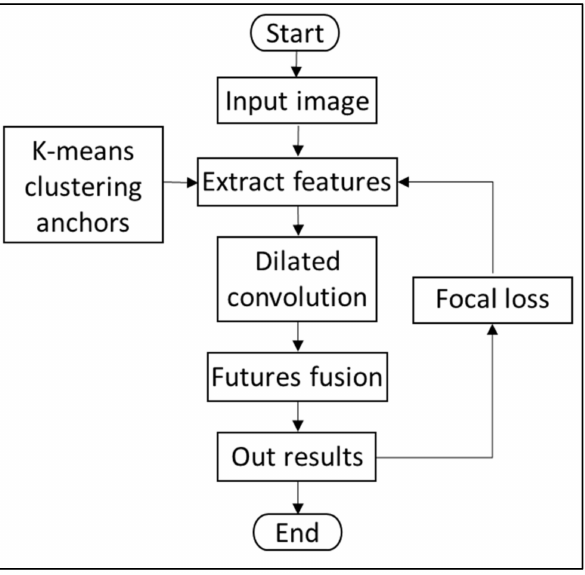
Figure 2. Flow chart of the improved